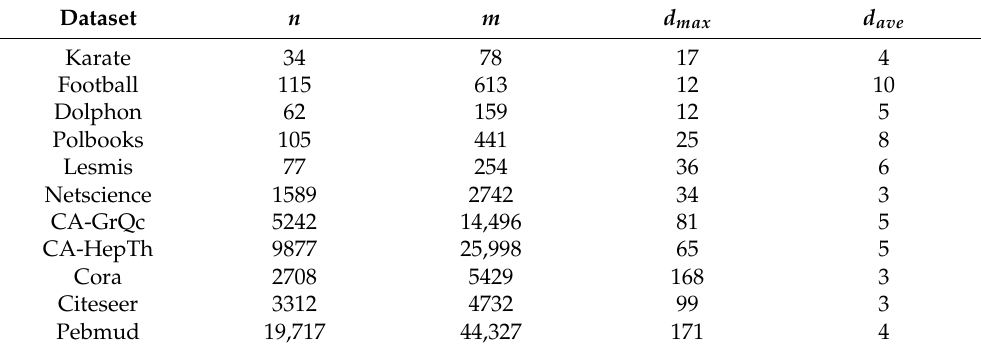
Table 2. The details of 11 networks.